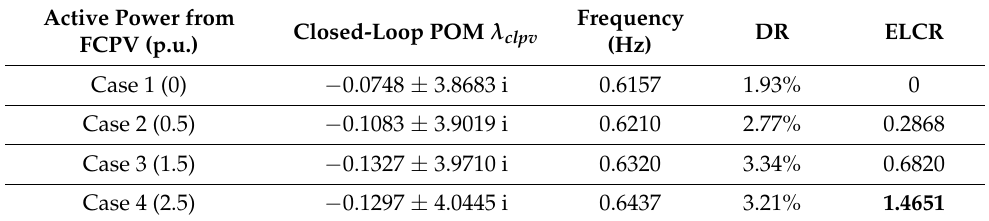
Table 4. Closed-loop modal analysis of POM